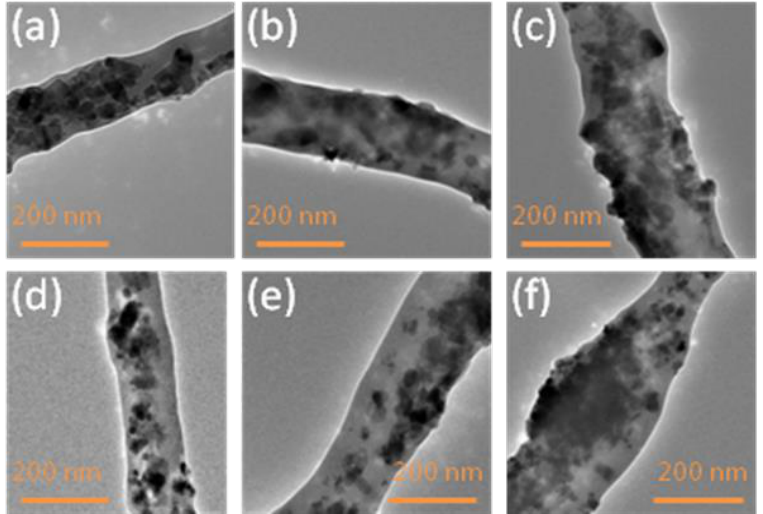
Figure 4. Transmission electron microscope (TEM) analysis of ( a ) 5% PVA/ZnO nanofibers; ( b ) 7% PVA/ZnO nanofibers; ( c ) 9% PVA/ZnO nanofibers; ( d ) 5% PVA/TiO 2 nanofibers; ( e ) 7% PVA/TiO 2 nanofibers; ( f ) 9% PVA/TiO 2 nanofibers.